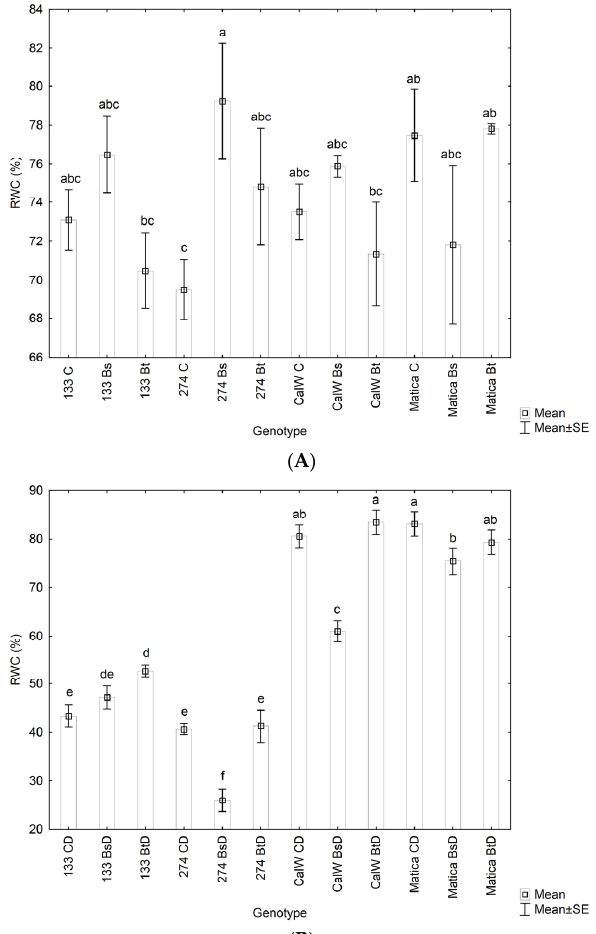
Figure 5. RWC (relative water content, %) in leaves of 133, 274, CalW, and Matica genotypes in ( A ) control (C) and ( B ) drought (D) conditions treated with two bacterial strains, B. safensis SS-2.7—Bs and B. thuringiensis SS-29.2—Bt. Different letters show significant differences between genotypes ( p < 0.05) according to Duncan’s test.